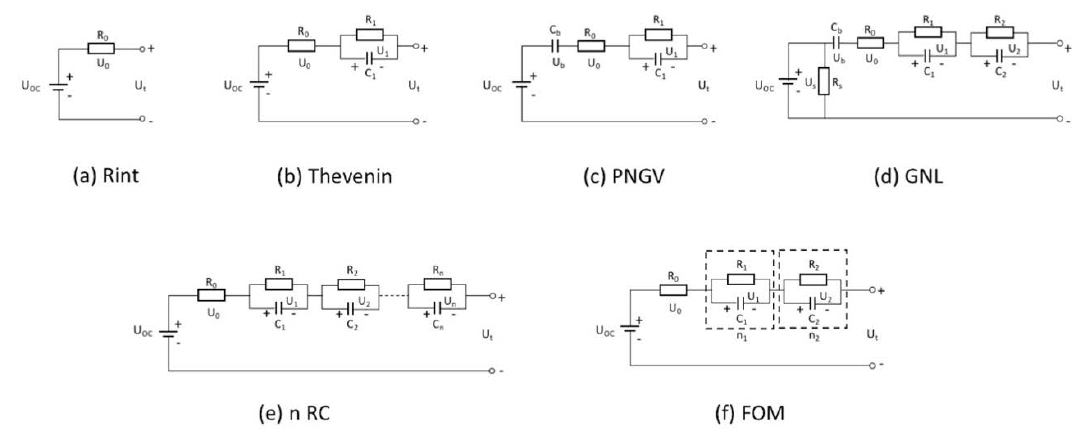
Figure 15. The commonly used battery electrical equivalent circuit model. Table 13. Battery ECM models and equations.